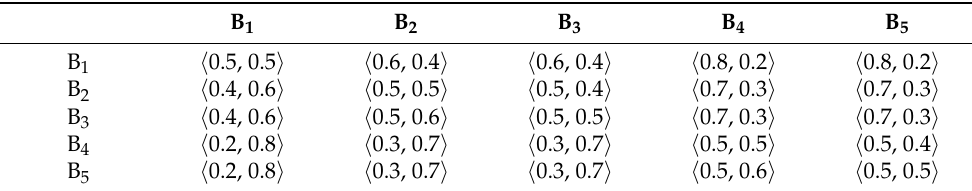
Table 8. Aggregated decision matrix in PF–AHP for the sub-criteria B ( CI = 0.0312977, CR = 0.0252401).